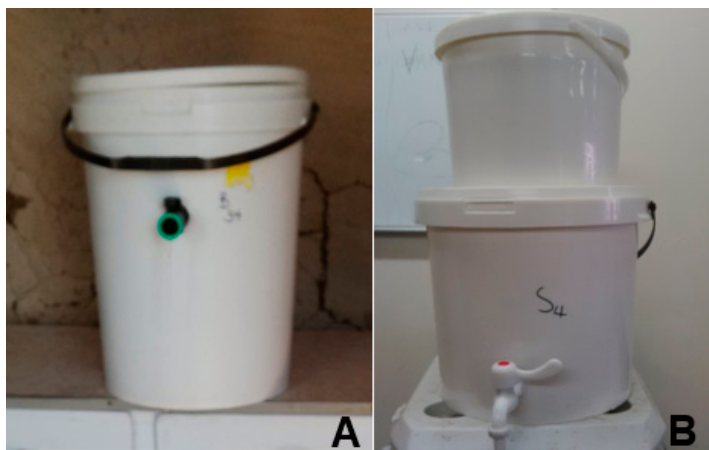
Figure 2. The Household water treatment systems (HWTS) implemented in Makwane Village; ( A ) BSZ-SICG filter and ( B ) SIPP filter.